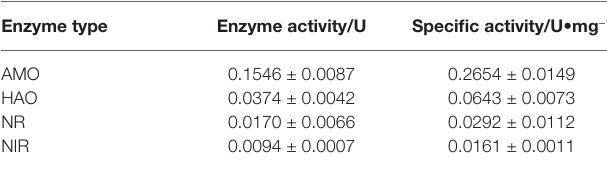
TABLE 1 | Enzyme activity and specific